Question: Produce a descriptive caption suitable for publication.
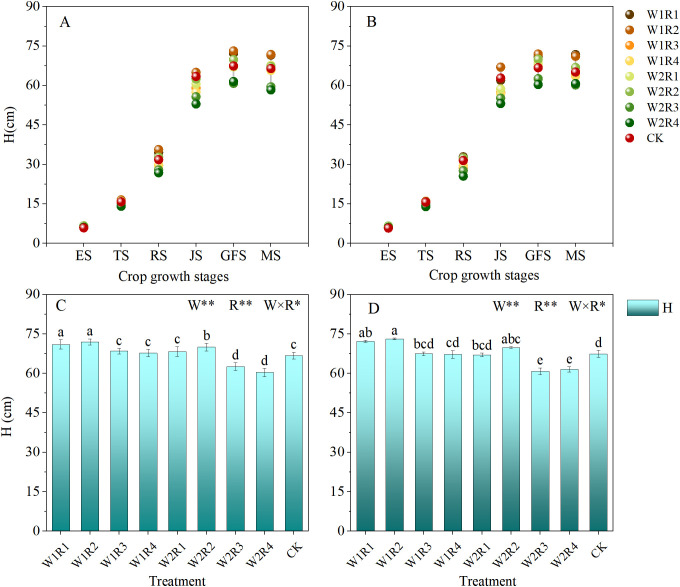
Answer: Changes in winter wheat plant height during the growing seasons in 2023-2025. (A, B) show changes in plant height as the growing season progressed in 2023–2024 and 2024-2025, respectively. (C, D) show bar charts of the analysis of variance (ANOVA) for plant height during the grain-filling stage in 2023–2024 and 2024-2025, respectively; Lowercase letters indicate significant differences among treatments (p< 0.05); W, real-time irrigation level; R, fertilizer-pesticide treatment; *p< 0.05, **p< 0.01.